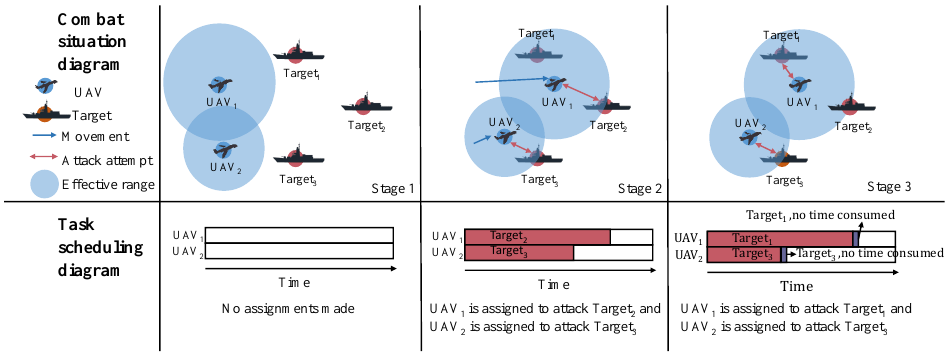
Figure 1. Example task assignment for UAV swarm saturation